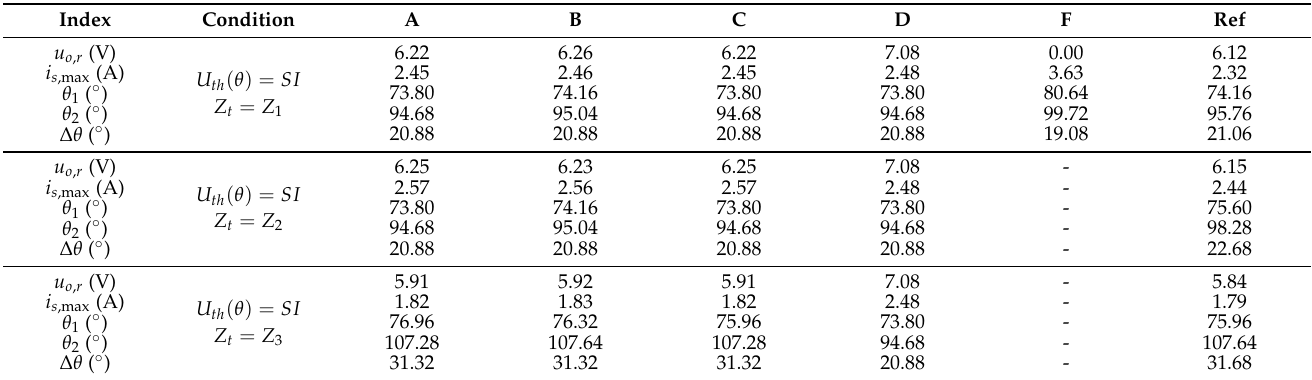
Table 5. Time-domain results obtained for different system impedance under sinusoidal volt- age source.